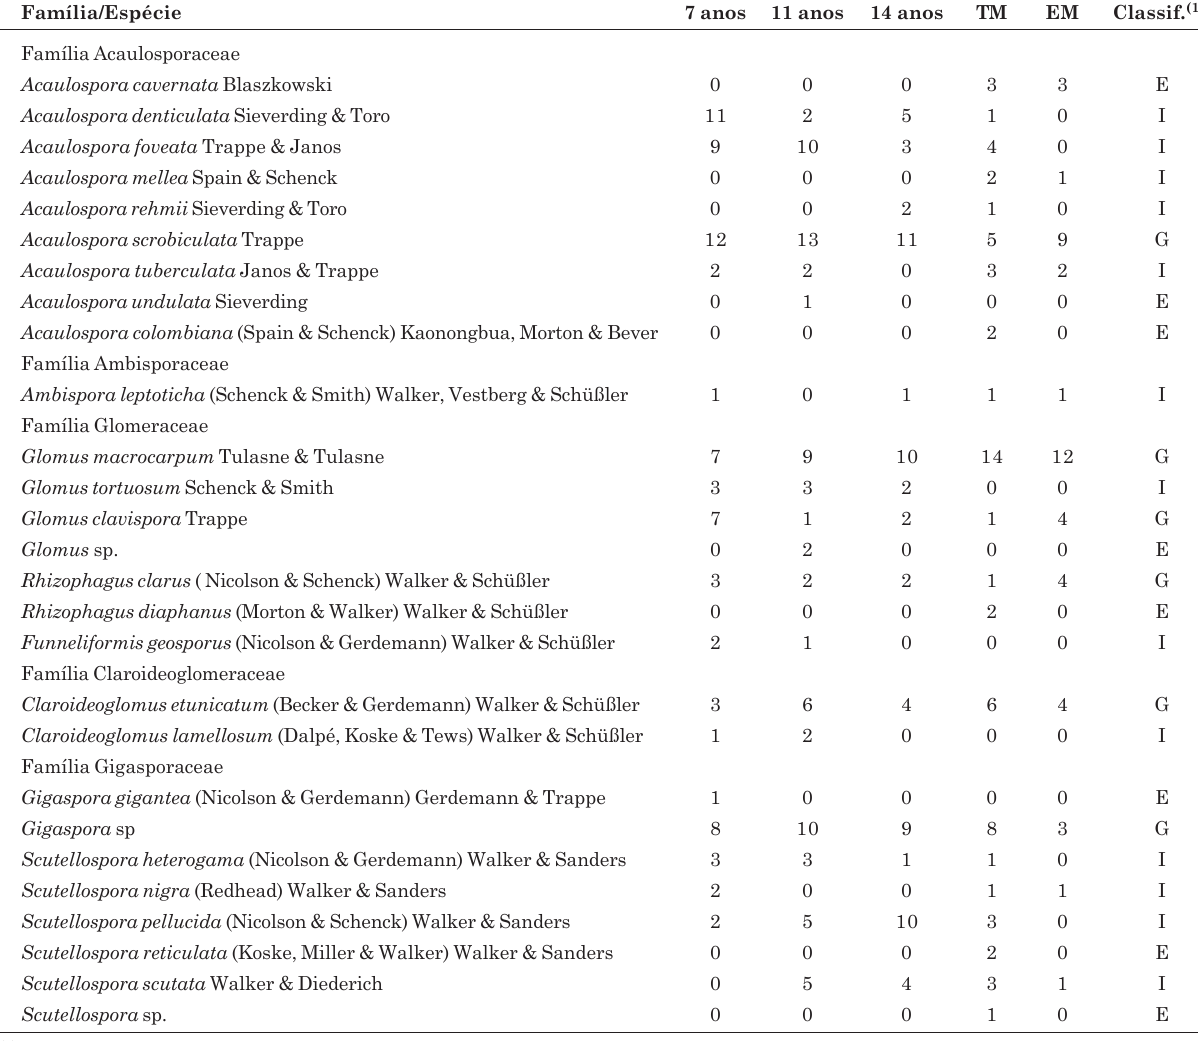
Quadro 3. Ocorrência de famílias e espécies e classificação dos fungos micorrízicos arbusculares recuperados na cronossequência de uso agrícola (7, 11 e 14 anos) e nas áreas sem alteração antrópica, no topo dos murundus (TM) e entre os murundus